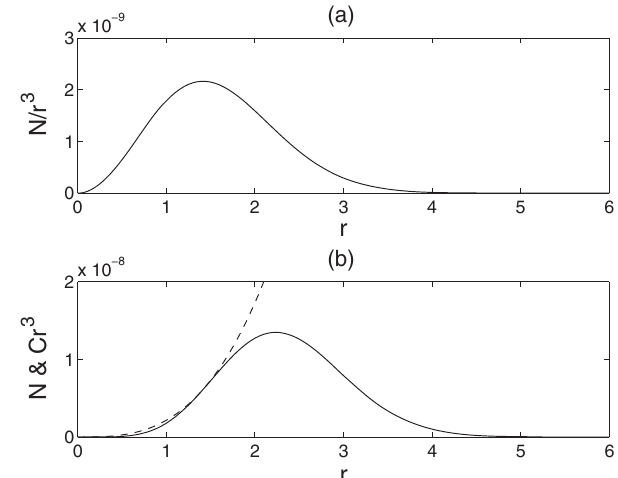
FIG. 4. In panel (a) the Von Mises stresses ( N ð r Þ =r 3 ) are in solid where the extremum is aligned with the intersection of the two curves in panel (b) containing the plots of N ð r Þ in solid and ˆ N ð r Þ ¼ Cr 3 in